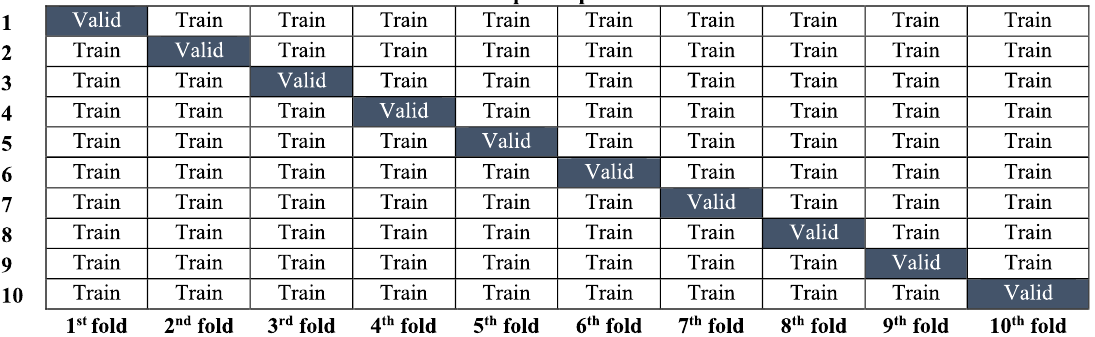
Figure 8. Illustration of k-fold cross